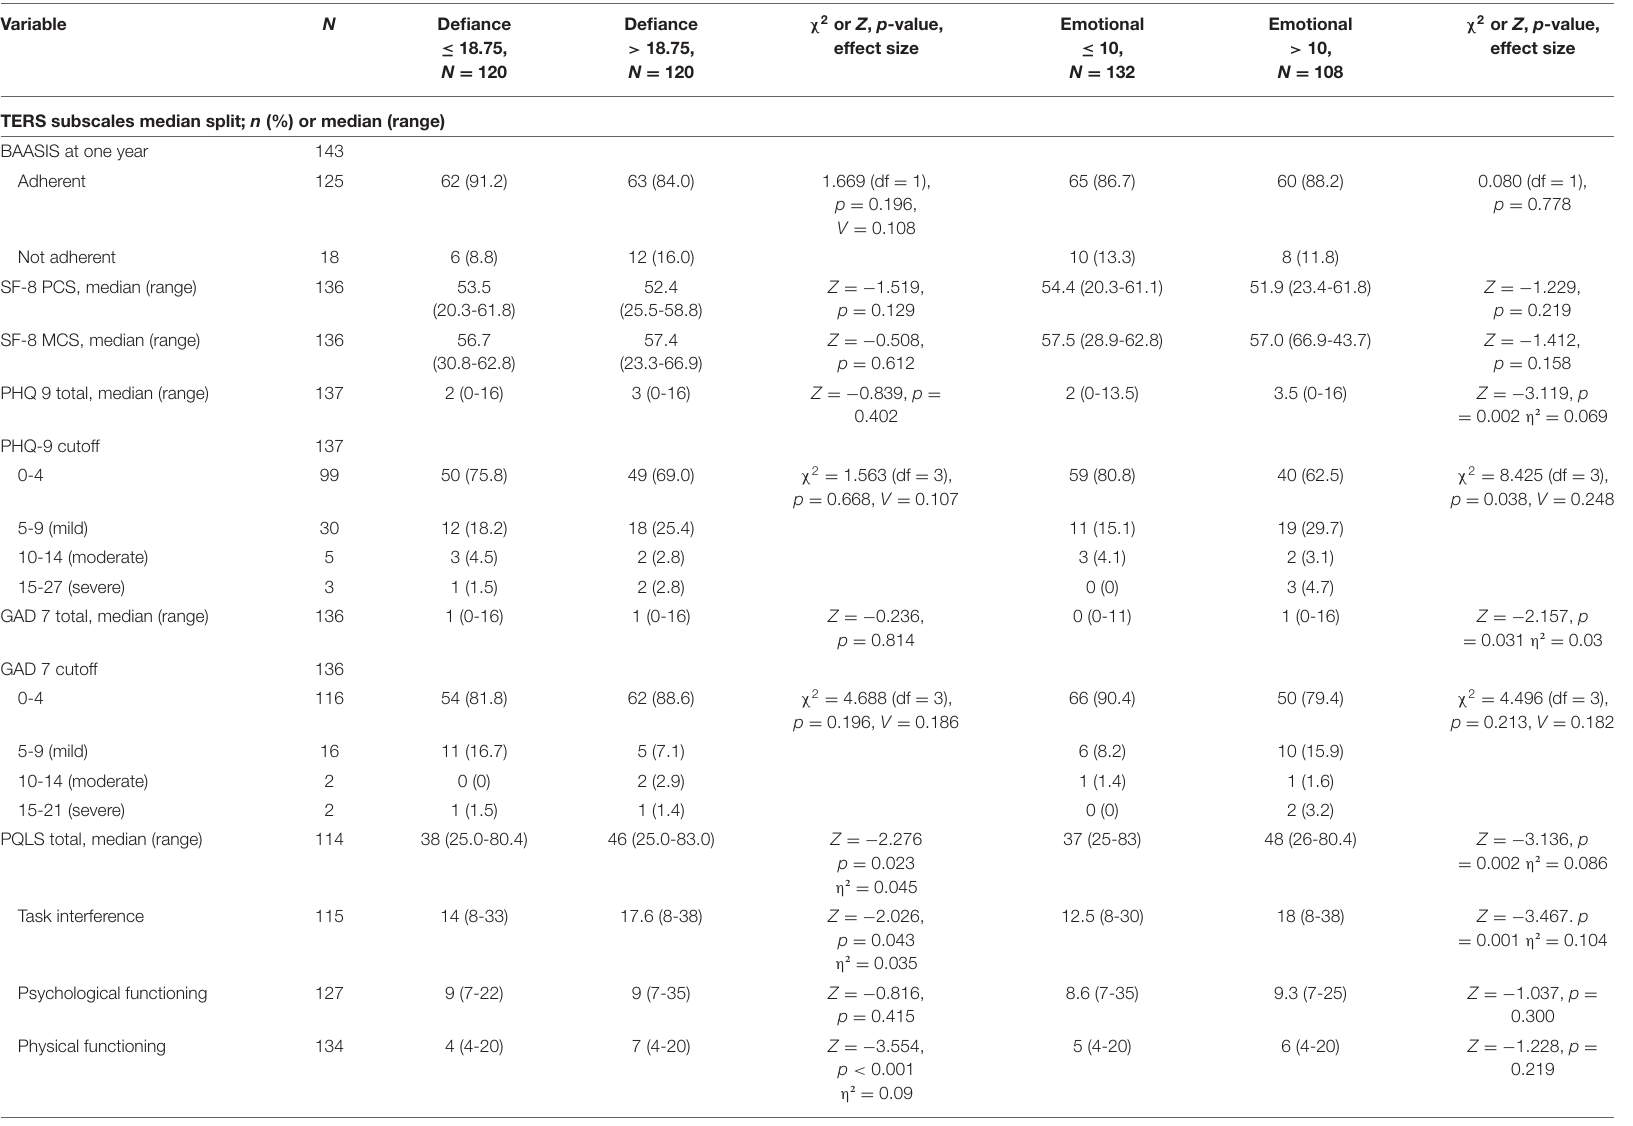
TABLE 7 | Comparison of extended 1-year follow-up outcomes divided by the TERS subscales “defiance” and “emotional sensitivity” (median split). Variable N Defiance